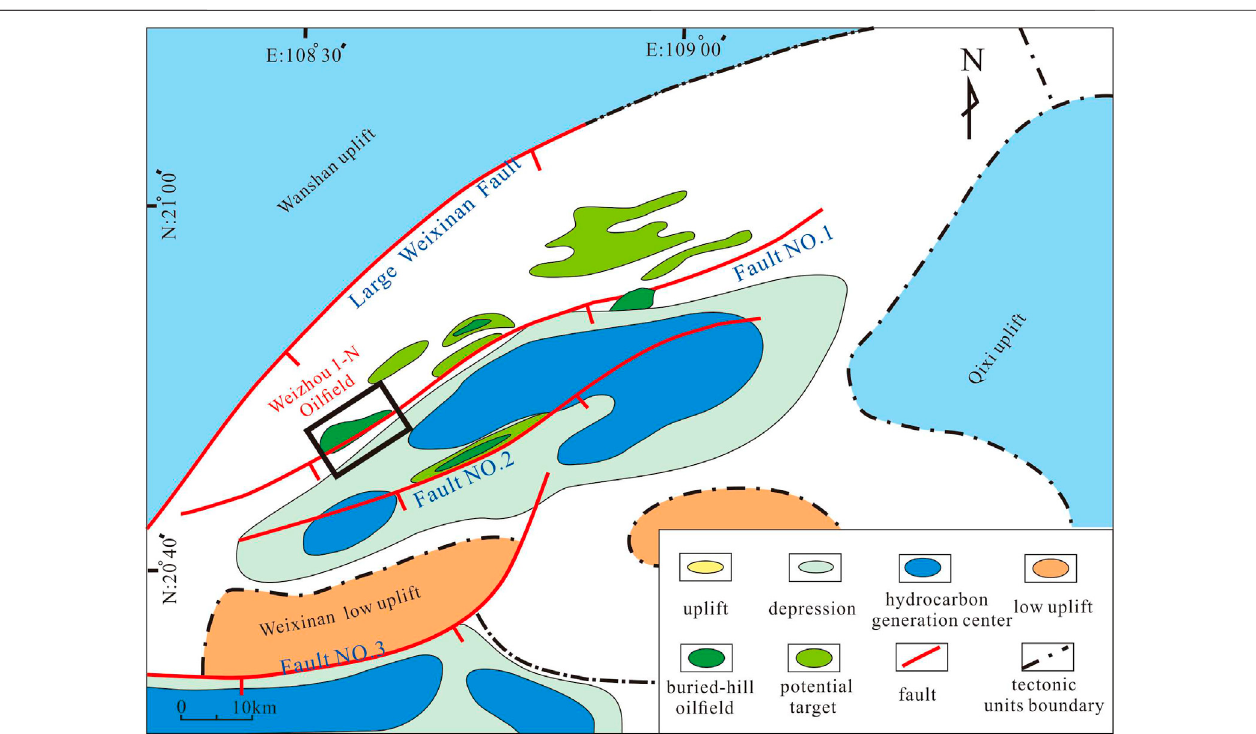
FIGURE 1 | Buried – hill distribution and tectonic location of the Weizhou 1 – N oil fi eld in the Weixinan Depression.